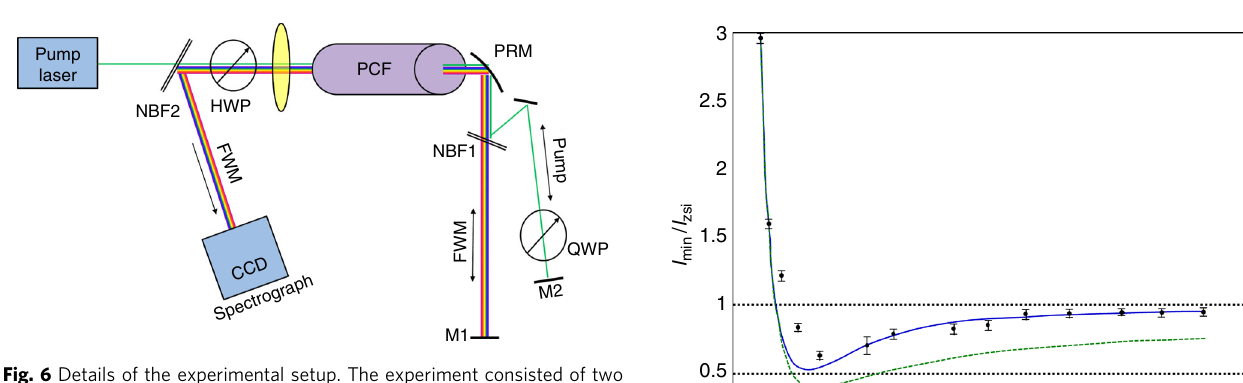
Fig. 6 Details of the experimental setup. The experiment consisted of two parts: (1) generation of broadband squeezed light (propagating from left to right) and then (2) homodyne measurement of the generated squeezing (propagating back from right to left). Broadband two-mode squeezed light is generated via spontaneous four-wave mixing (FWM) in a photonic crystal fi ber (PCF) pumped by 12 ps laser pulses (786 nm) (collimated at the output with a parabolic mirror PRM). After generation, the pump and the FWM are separated into two paths by a narrowband fi lter (NBF1) allowing the pump phase and polarization to be tuned independently. Both pump and FWM are re fl ected back by folding mirrors (M1, M2) for a second pass through the PCF, now acting as a measuring device. The speci fi c FWM quadrature to be ampli fi ed is selected by tuning the pump phase, and the ampli fi cation gain is controlled by manipulation of the pump polarization using the half-wave and quarter-wave plate (HWP, QWP) before the fi ber and after it. After the second (measurement) pass through the PCF, the FWM fi eld is separated from the pump by a narrowband fi lter (NBF2) and directed towards a CCD spectrograph, where the ampli fi ed spectrum is measured